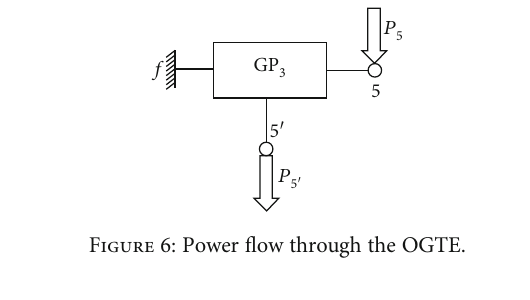
Figure 8: Power fl ow when ω